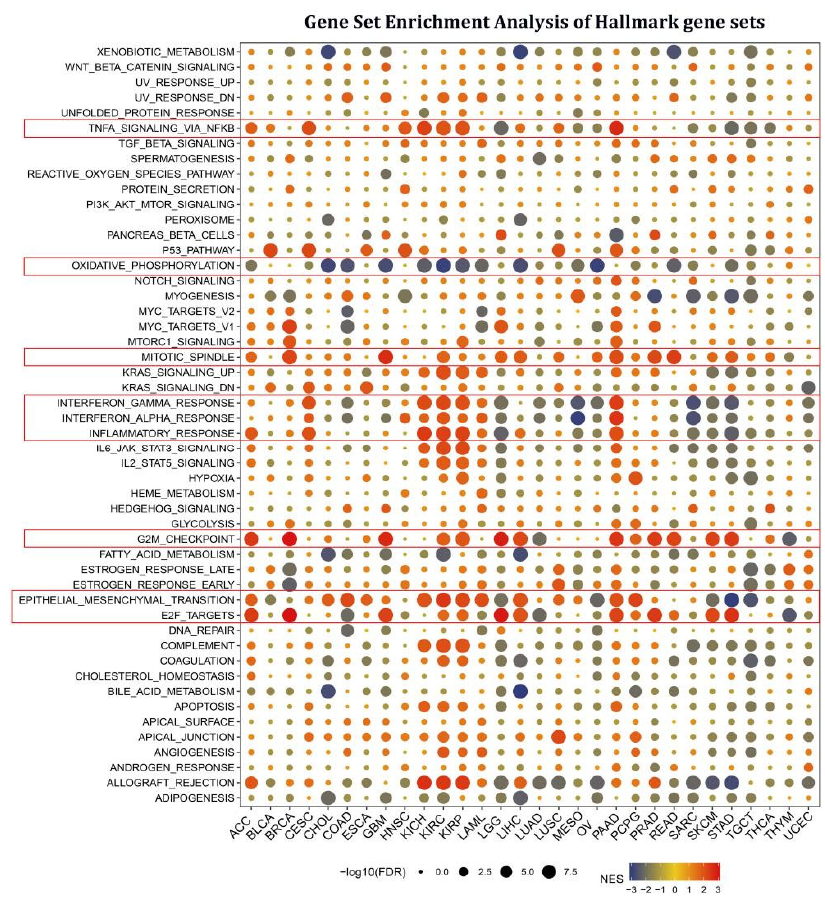
Figure 3. STX6 is involved in EMT, cell cycle, and tumor immunity in pan-cancer via gene set enrichment analysis of hallmark gene sets. STX6 expression was favorably connected to the mitotic spindle, G2M checkpoint, and epithelial–mesenchymal transition. Moreover, STX6 was also linked to TNFA signaling via NFKB, IFN- α , IFN- β , and inflammation, as well as allograft-rejection pathways in kidney cancer (KICH, KIRC, and KIRP), CESC, and PAAD; however, this was not the case for other cancers, including LGG, MESO, OV, SARC, SKCM, and STAD, where STX6 inhibits cellular oxidative phosphorylation. Table 1. Immune and stromal scores of STX6 in